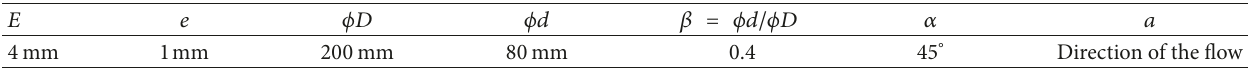
Table 10: Geometry of the diaphragm.